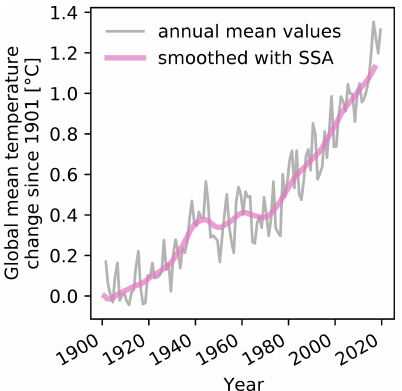
Figure 3. Time series of GMT change since 1901 derived from GSWP3-W5E5 near-surface air temperature data. Shown are an- nual mean GMT change (gray) and GMT change smoothed by SSA with a smoothing window of 10 years (pink). The smoothed GMT change is used as the predictor of regional climate change in our detrending model (denoted by T in the